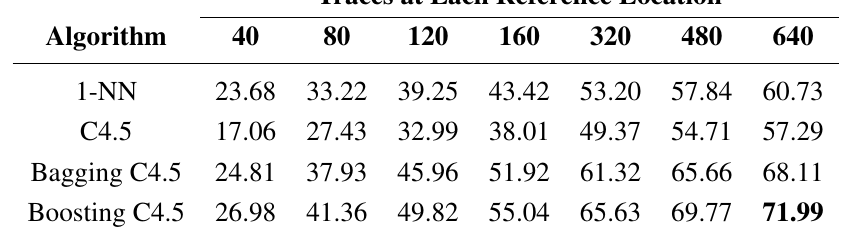
Table 3. Correctly classified instances (%) for different classification methods and training